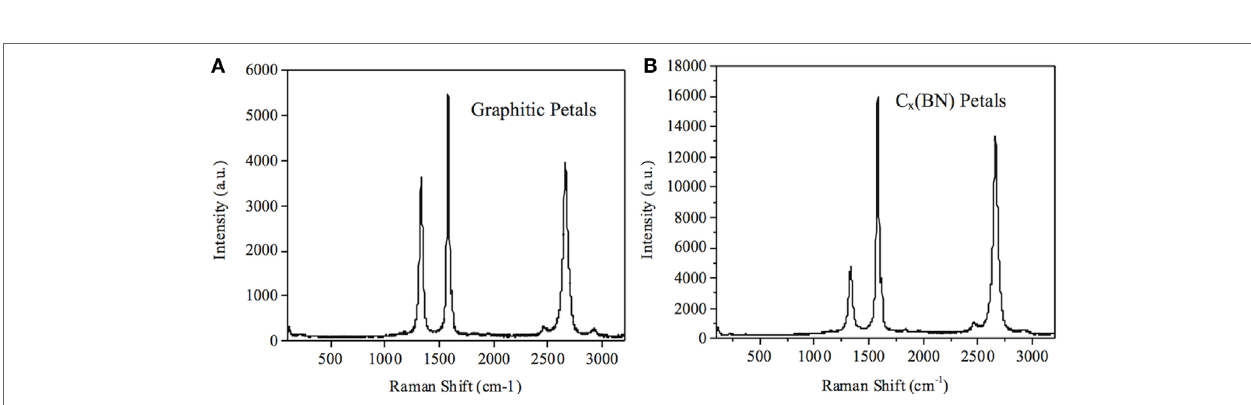
FigUre 2 | Raman spectra of graphitic petals (GPs) (a) and boron nitride modified GP arrays (B) .